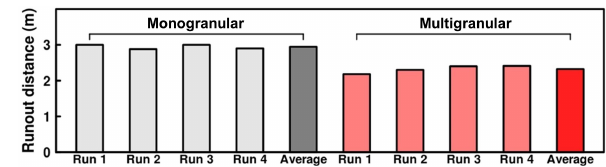
Figure 5. Comparison of the total runout distance of the fronts of the solid phase of monogranular and multigranular flows. The loca- tions of the fronts of the solid phase are depicted by white lines in Fig.